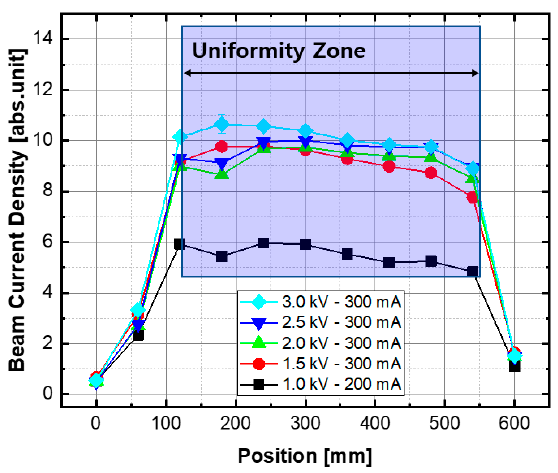
Figure 4. Current density profile of HDS LIS module.